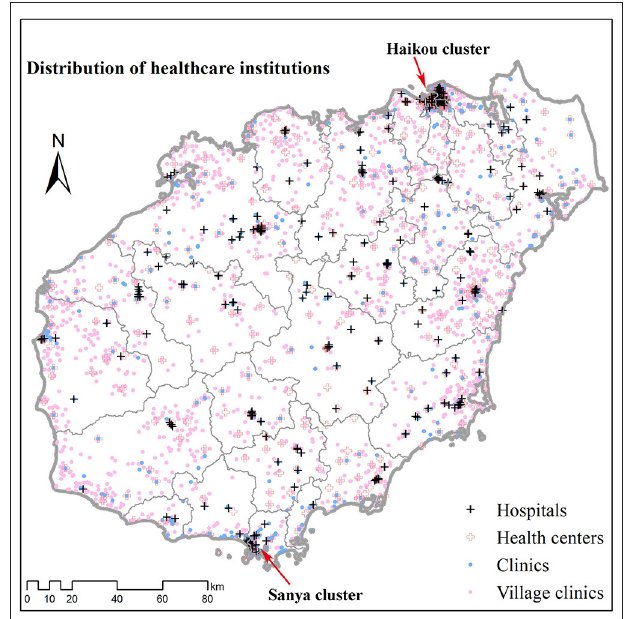
FIGURE 2 | Distribution of healthcare institutions on Hainan Island (2018). Healthcare institution data including hospitals, health centers, clinics, and village clinics were provided by the Health Bureau of Hainan Province. All healthcare institutions were geocoded by address using Baidu Map.